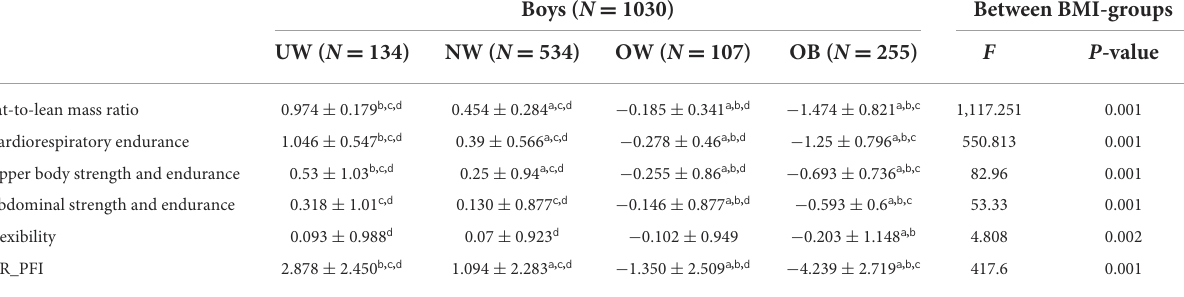
TABLE 4 Mean Z- score of health-related physical fitness components of male participants by BMI category.